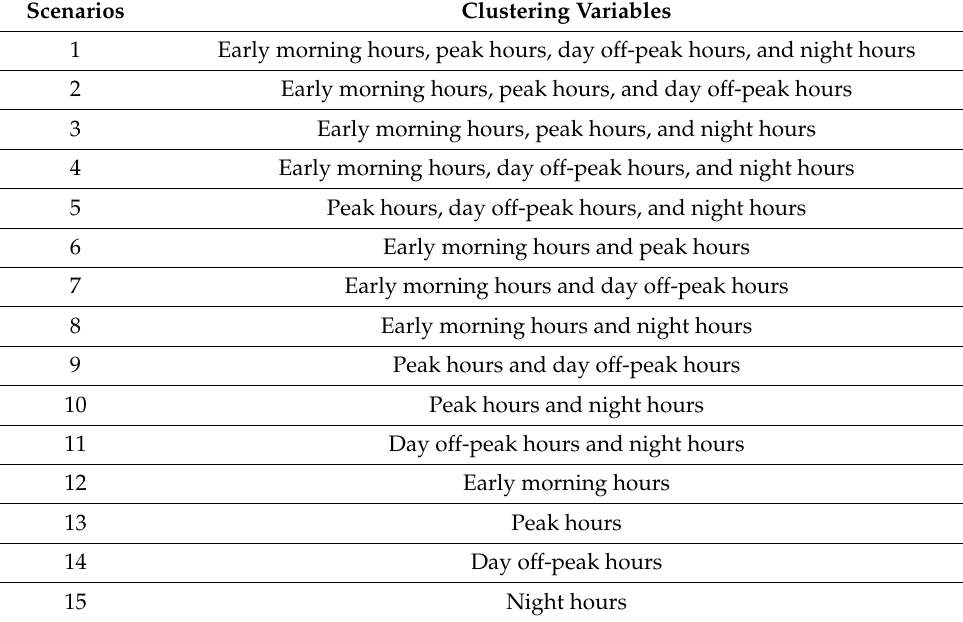
Table 4. Scenarios for clustering